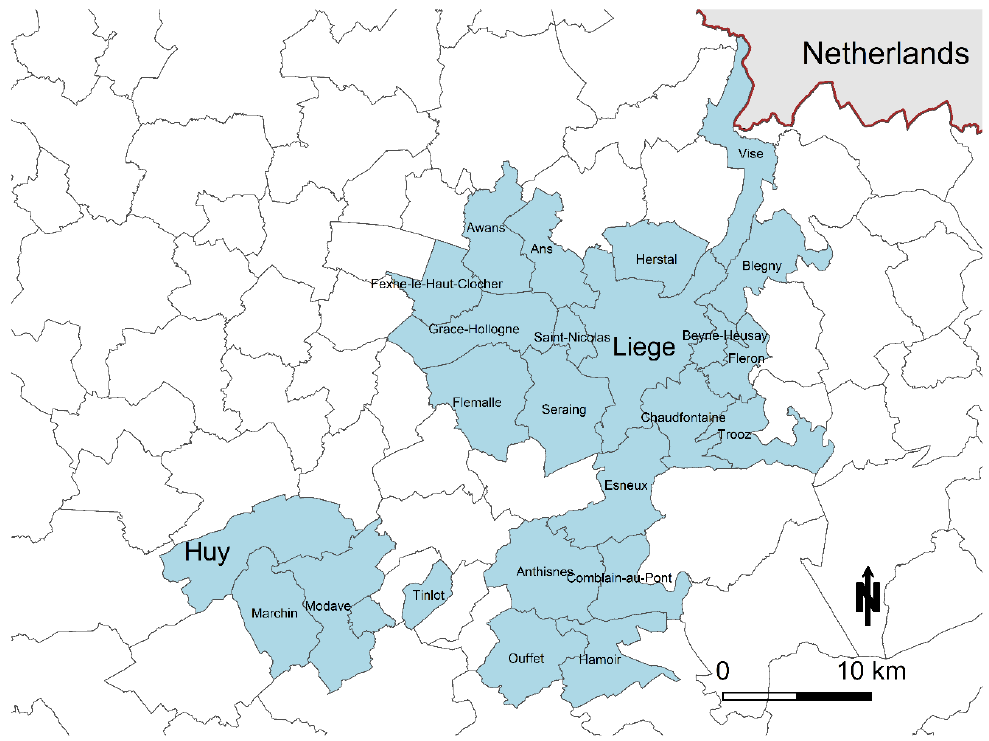
Figure 1. Map of CILE (Compagnie Intercommunale Liégeoise des Eaux) service area.